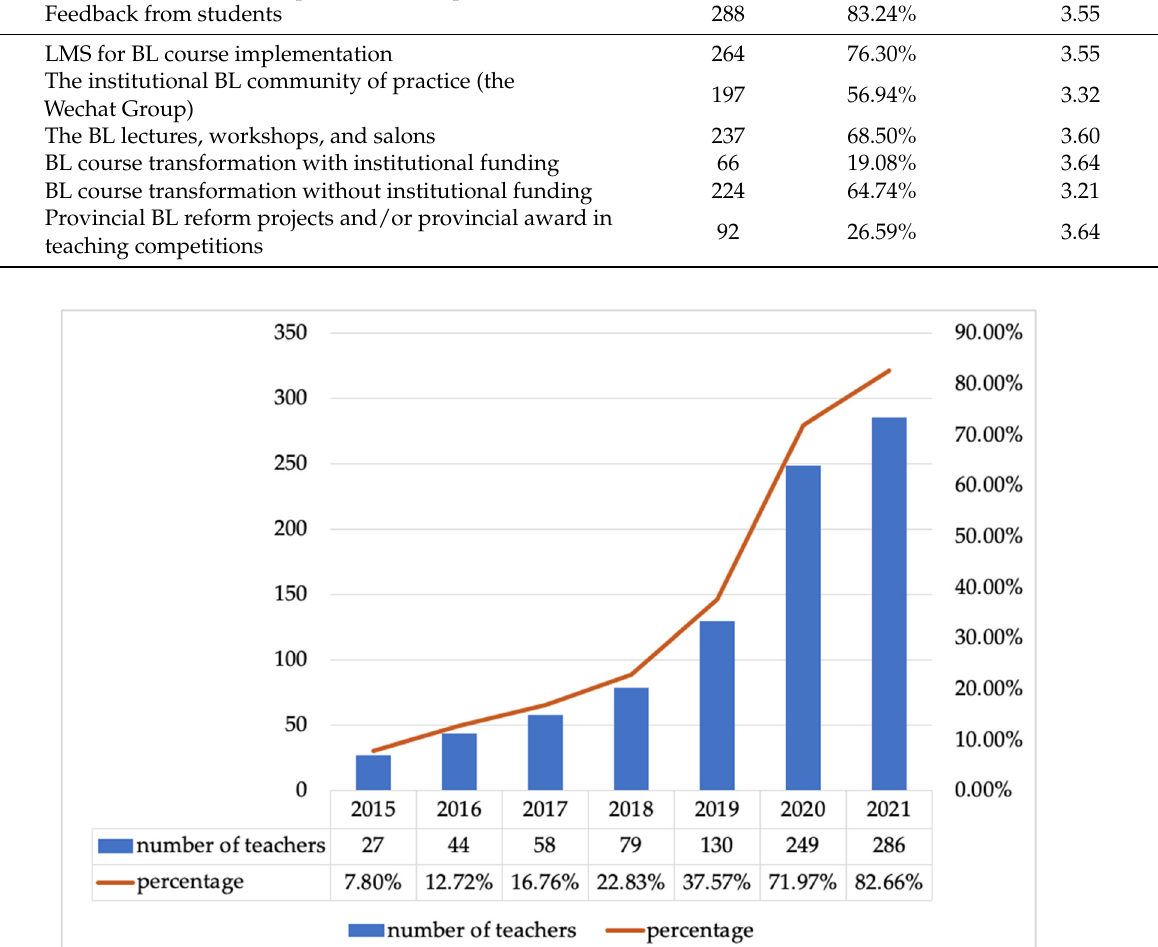
Figure 4. Number of instructors who joined S university’s BL reform.